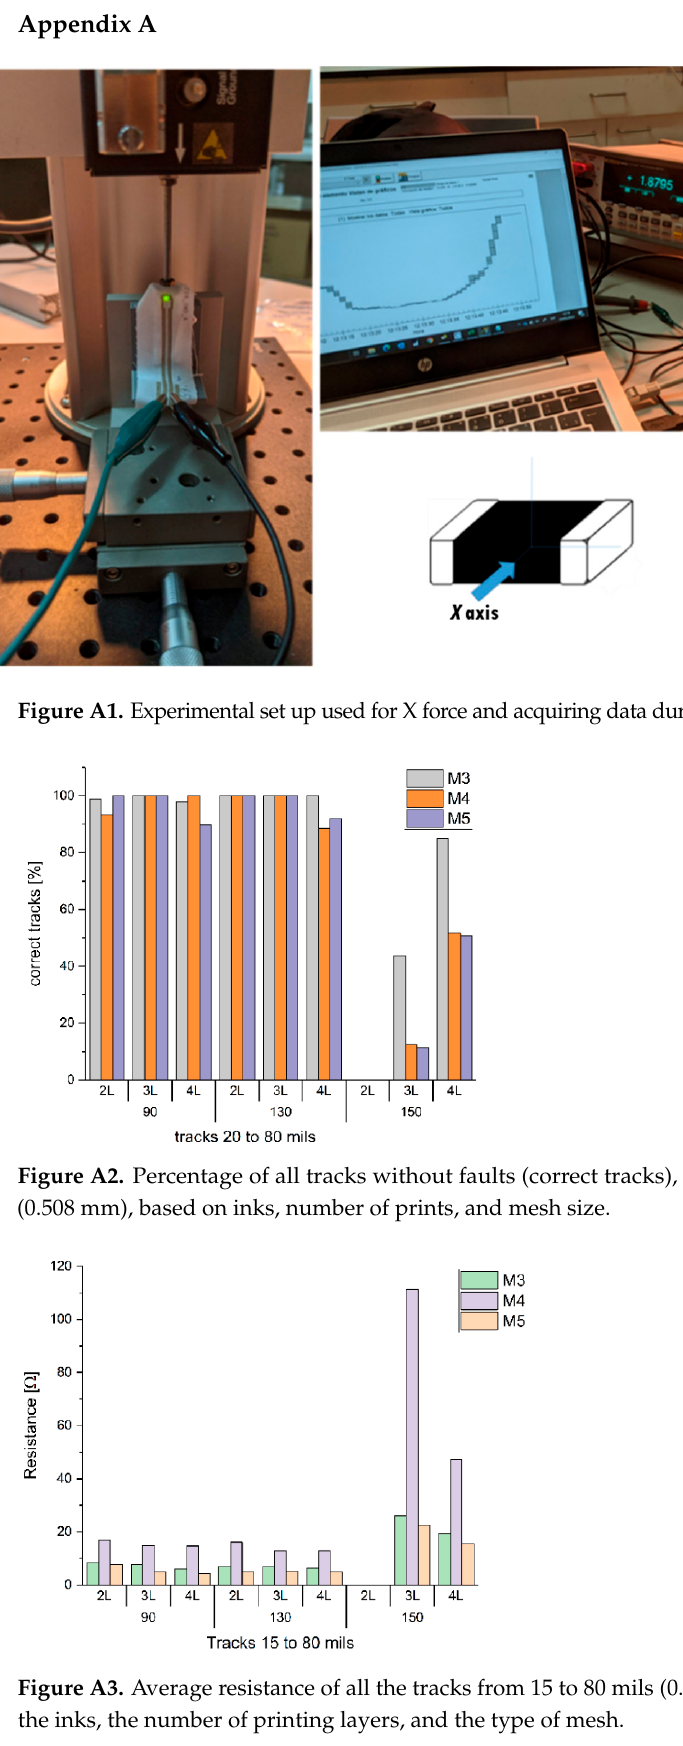
Figure A4. Resistance and shear force variation in the shear test for a 10 k Ω resistor with a 0805 encapsulated.